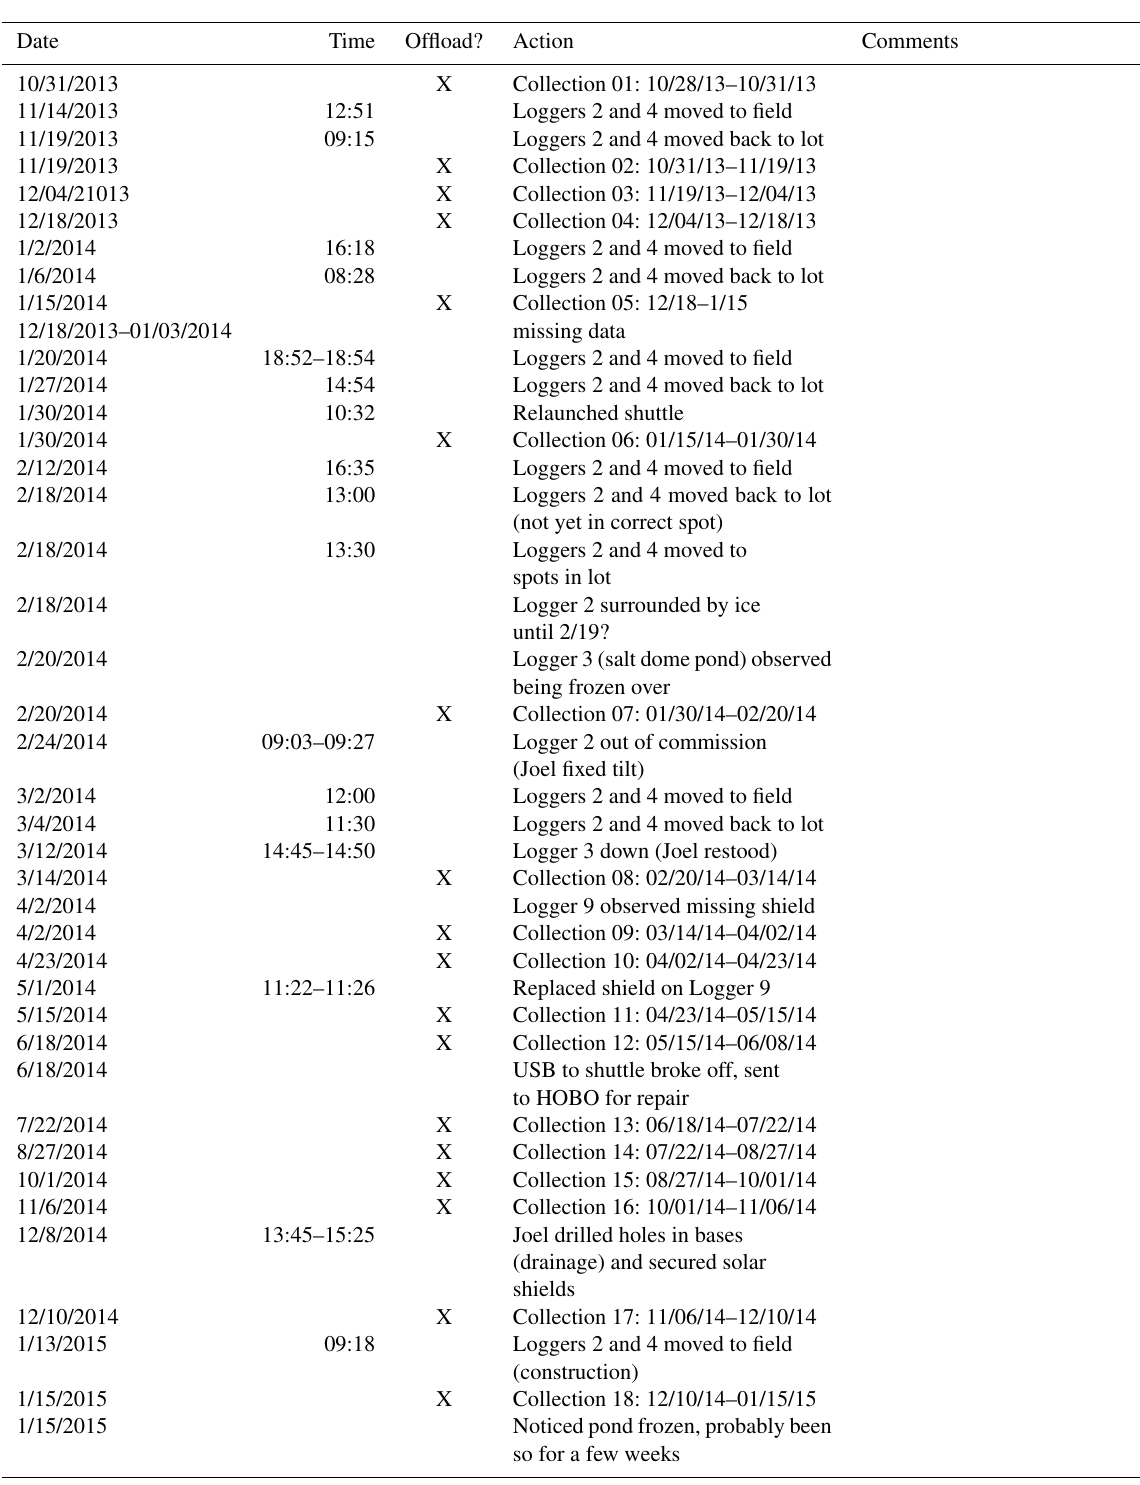
Table 3. Log of events recorded during the study period. Date format is